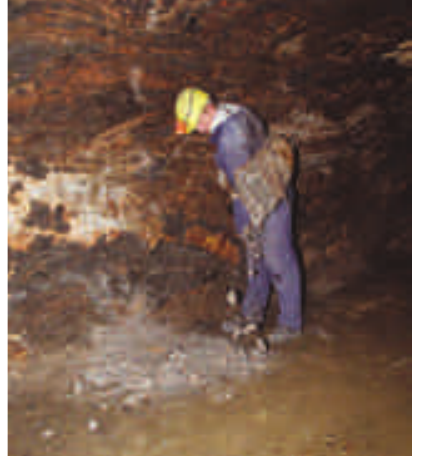
Figure 5 Reconstruction showing how the